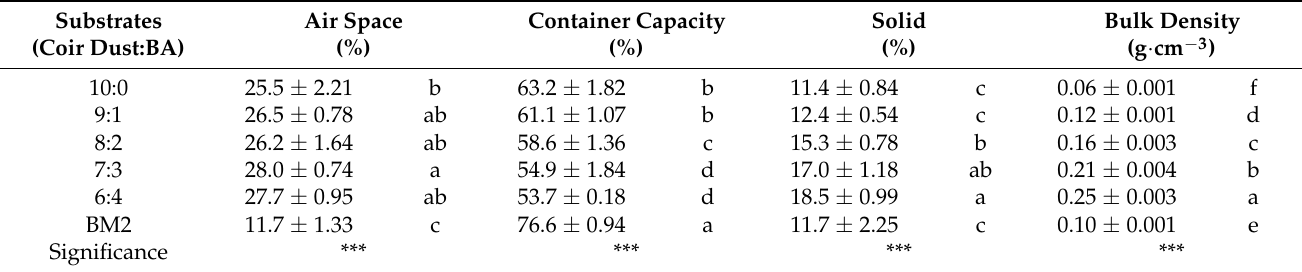
Figure 1. Particle size distributions in mixed coir dust and coal bottom ash (BA) substrates, and in a commercial germinating mixture BM2. Table 1. Percentages of air space, container capacity, and solid matter in mixed coir dust and coal bottom ash (BA) substrates and in a commercial germinating mixture